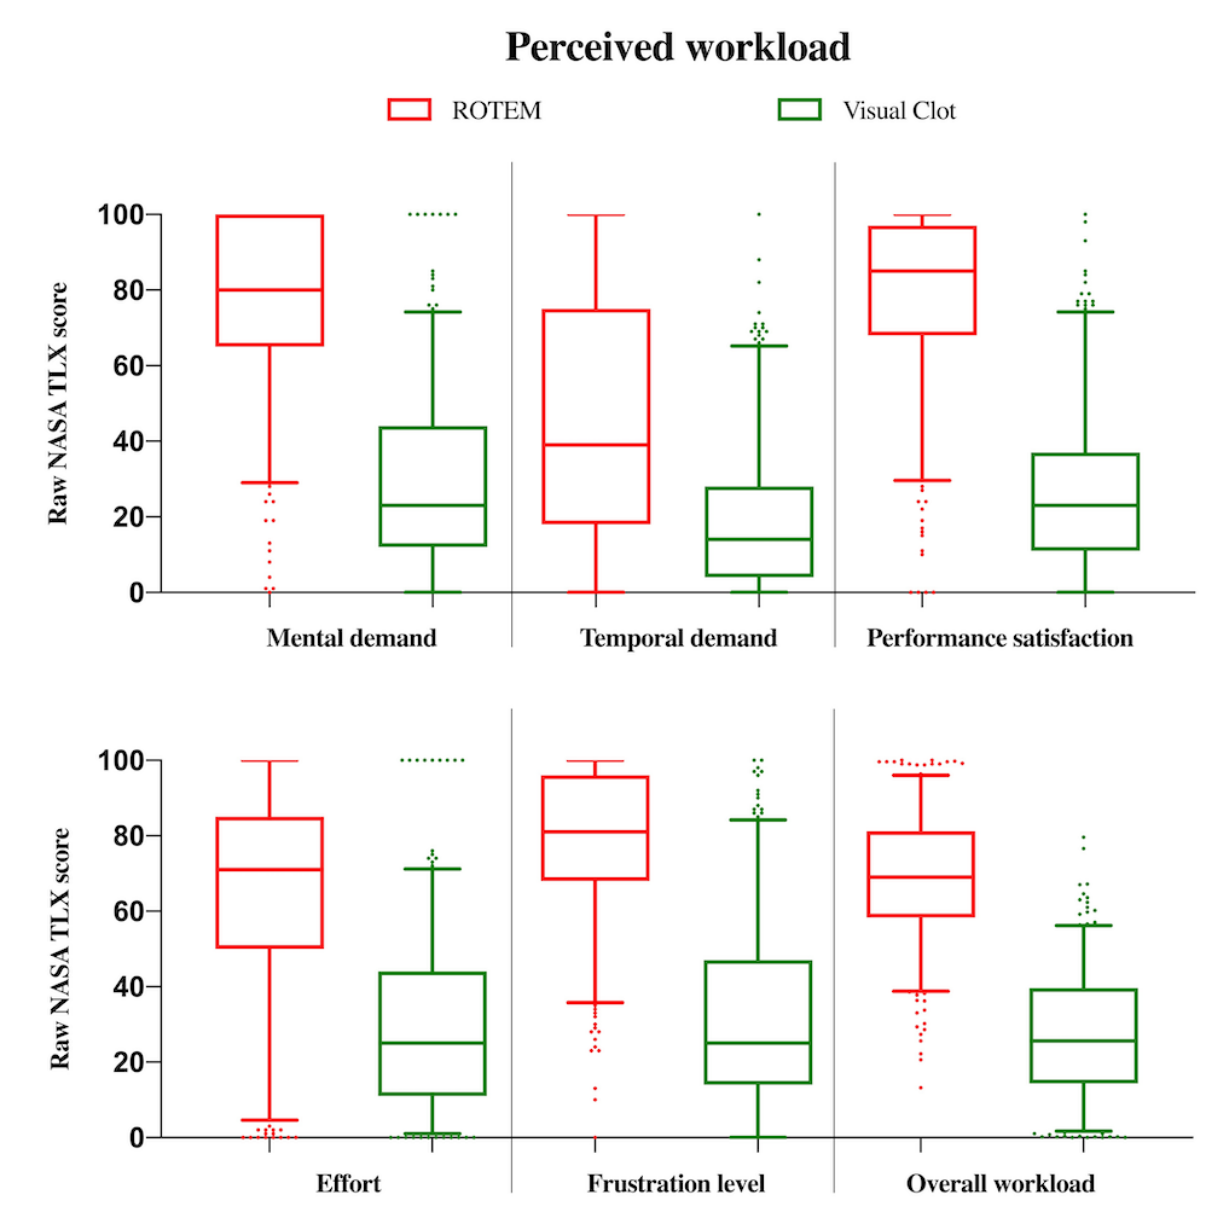
Figure 4. Boxplots representing the analysis of the participants’ perceived workload after using the respective viscoelastic modality. The overall workload and its subscores were evaluated using the modified, raw NASA Task Load Index questionnaire. Low workload scores correspond to low perceived workload. The box represents the first and third quartiles, with the line indicating the median. N=315 per viscoelastic modality. The whiskers represent the 5th and 95th percentile. NASA: National Aeronautics and Space Administration; ROTEM: rotational thromboelastometry; TLX: Task Load